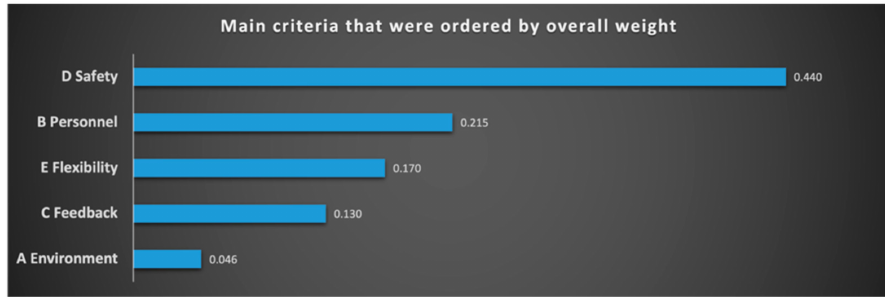
Figure 5. The overall weight and ranking of five main criteria.